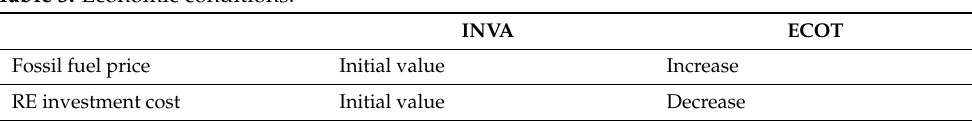
Table 3. Economic